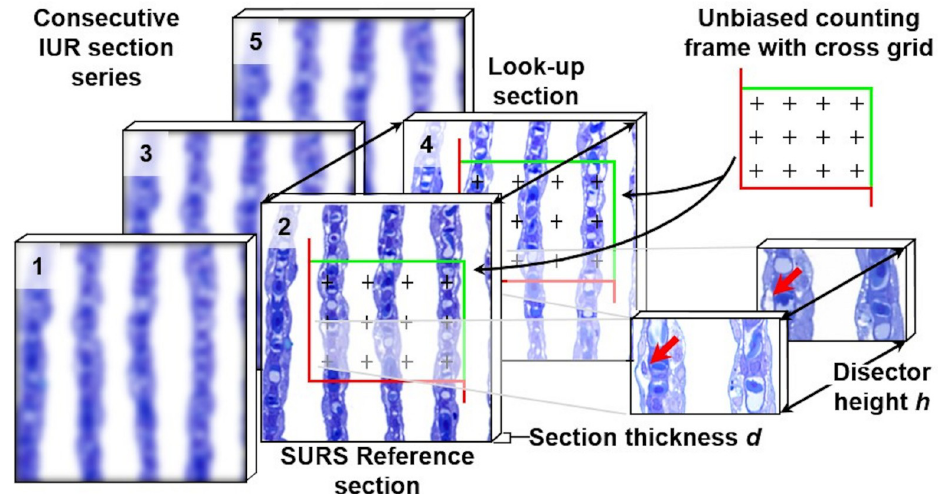
Fig 14. Estimation of the numerical volume density of epithelial cells in the secondary gill lamellae. The number of epithelial cells (EC) per volume unit of secondary lamellae (SL) is estimated, using the physical disector as a 3-D stereological test system for unbiased counting of particles. A physical disector consists of two parallel histological sections (a reference section and a look-up section) with a defined distance (disector height, h). The reference section is SUR sampled from a series of technically impeccable, parallel, consecutive sections with a defined nominal section thickness. The factual physical thickness of the sections (d) defines the disector height. The present example shows corresponding fields of view in a series of 5 consecutive, toluidine blue stained, semithin IUR GF sections with a nominal thickness of 0.5 μ m (the examined fields of view in the section are SUR sampled at the given factor of magnification). From the series of five sections, the second section is SUR sampled as reference section. The fourth section ( i . e ., with a distance of h = 2 x d = 2 x 0.5 μ m = 1 μ m) is defined as look-up section. Corresponding section areas in the reference- and the look-up section are overlaid with an unbiased counting frame [110] of known area and a cross grid of equally spaced test points. The volume of the reference compartment defined by the disector probe, i . e ., the volume of SL within the 3-D space defined by both sections of the disector, is given by the disector height and the mean area of the SL section profile(s) ( i . e ., the reference compartment) present in the reference- and the look-up section. The section area of SL within the area of the unbiased counting frame is determined by point counting: the number of crosses hitting SL section profiles is counted and multiplied by the area associated with a single point/cross of the grid ( i . e ., the quotient of the number of crosses in the counting frame and the area of the counting frame). SL-EC nuclei that are sectioned in the reference section, but not in the look-up section are counted (Q - ), using the unbiased counting frame (particle sections are only counted if they are completely located within the unbiased counting frame or if they touch one of the “acceptance” (green) border lines. Any particle section profiles touching an “exclusion” (red) line are not counted) [25]. In the presented example, a SL-EC nucleus section profile that is present in the reference section, but absent in the look-up section, is indicated by red arrows. The numerical volume density of the SL-EC is then calculated from the EC number counted in all sections of all samples per case in all analyzed disectors and the cumulative reference compartment (SL) volume in all analyzed disectors ( Eq 8 ). appropriately aligned and superimposed with unbiased counting frames of known area [25,110].For images representing section areas of approximately 500 μ mx 300 μ m—230 μ mx 150 μ m,counting frame areas between 200 μ mx 100 μ mand 150 μ mx 70 μ mare recommended. Following the rules for sampling and counting of particles with the unbiased counting frame ( Fig14 ),the number of nuclear profiles of the cell type of interest (SL-EC) present in the reference section and absent in the look-up section is counted (Q - ) [107].The section profile area of the SL reference compartment within the unbiased counting frame is determined by point counting ( Sections11 and 12 )[24,26].The SL volume within the disector volume is then determined from the quotient of the mean SL section pro- file area within the unbiased counting frames in the reference- and the look-up section and the (known) area of the unbiased counting frame. N is calculated from the number of EC (Q - ) V(EC/SL) counted in all analyzed disectors per case and the cumulative volume of the SL in these disectors ( Eq 8 ).To obtain reliable numerical volume estimates, at least 50 nuclei ( i . e .,Q - , particles, cells) should be counted per case.